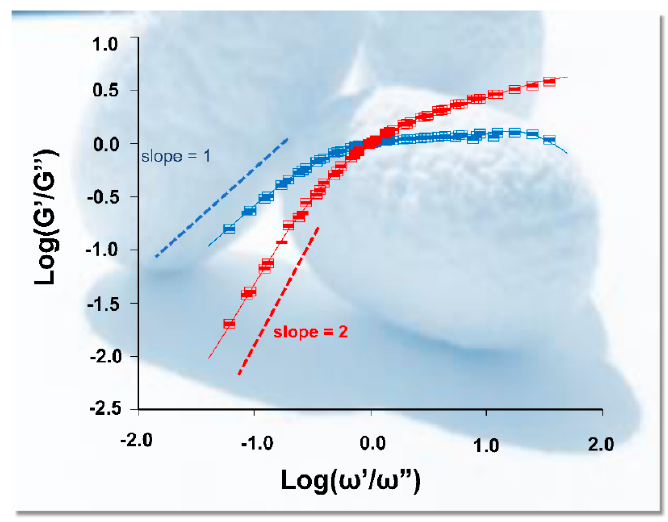
Figure 4. The relationship between loss factor and frequencies of SF. Reproduced with permission from [69]. Copyright 2016, American Chemical Society.